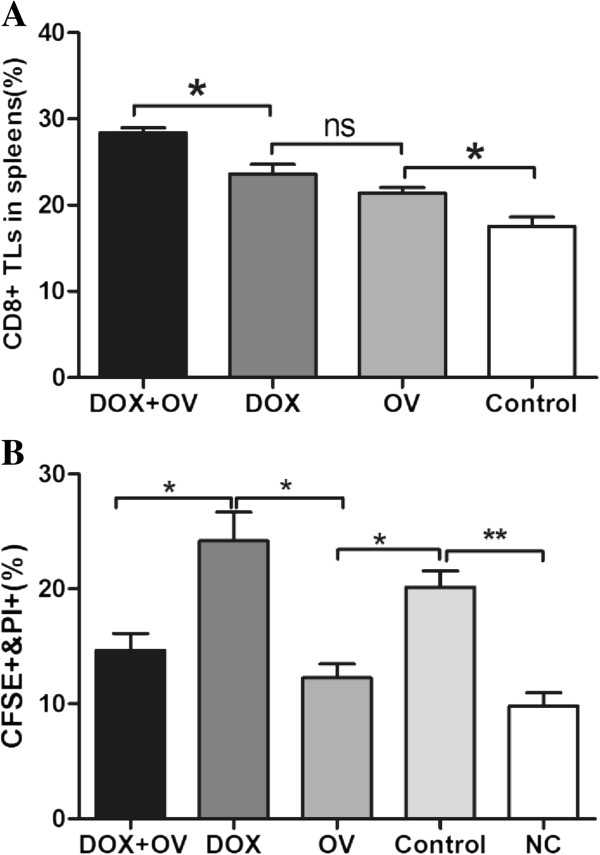
Cytotoxic activity to 4T1 ALDHbr of CD8+ T lymphocytes from mice following different therapies. (A) The proportion of CD8+ T lymphocytes in spleens after treatments. (B) CD8+ T lymphocyte cytotoxicity to 4T1 ALDHbr by CFSE/PI flow cytometry. Negative control splenocytes were taken from tumor-free naive mice. Statistical analysis was performed using the unpaired Student’s t test: *, p < 0.05; **, p < 0.01; ns, not significant. Abbreviations: DOX, doxorubicin; OV, oncolytic HSV1-hGM-CSF; TLs, T lymphocytes; NC, negative control.